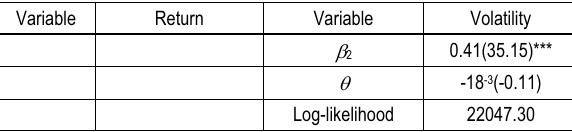
plus the previous day’s volatility and negative noise on the next Table 6 (cont.). Empirical results for the AR (1)-E-GARCH (1,1) model model which has two dummy variables which explain the impact of the change of ruling party and the 1987 stock market